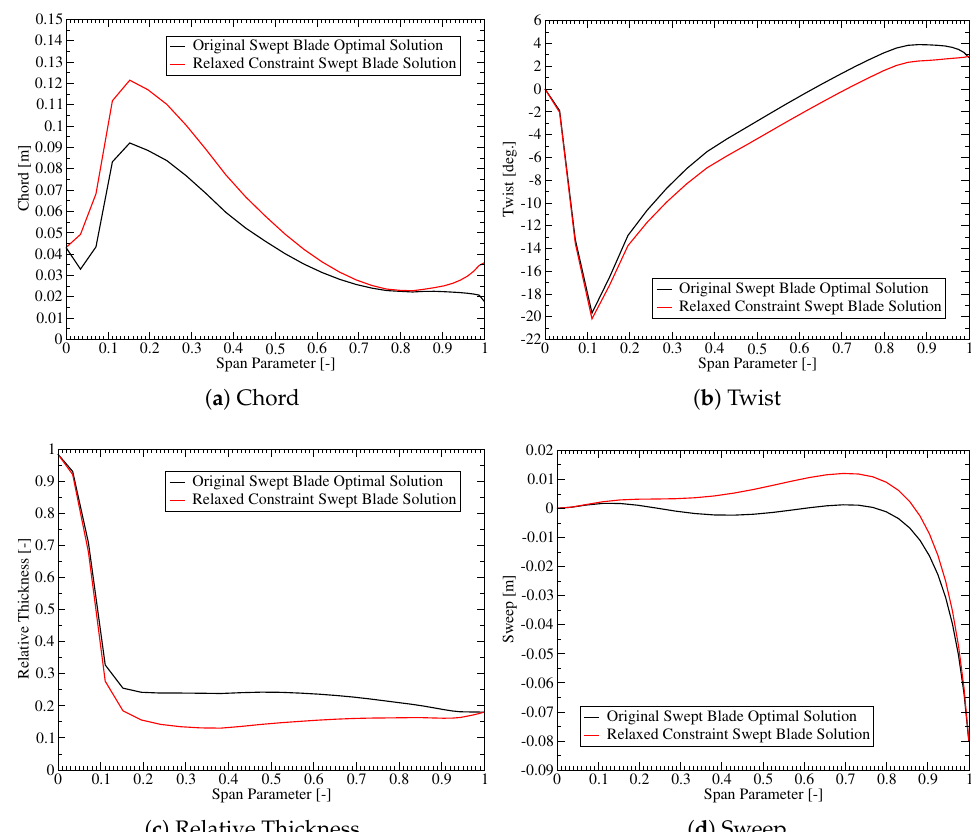
Figure 11. The impact of the thrust constraint on selected design